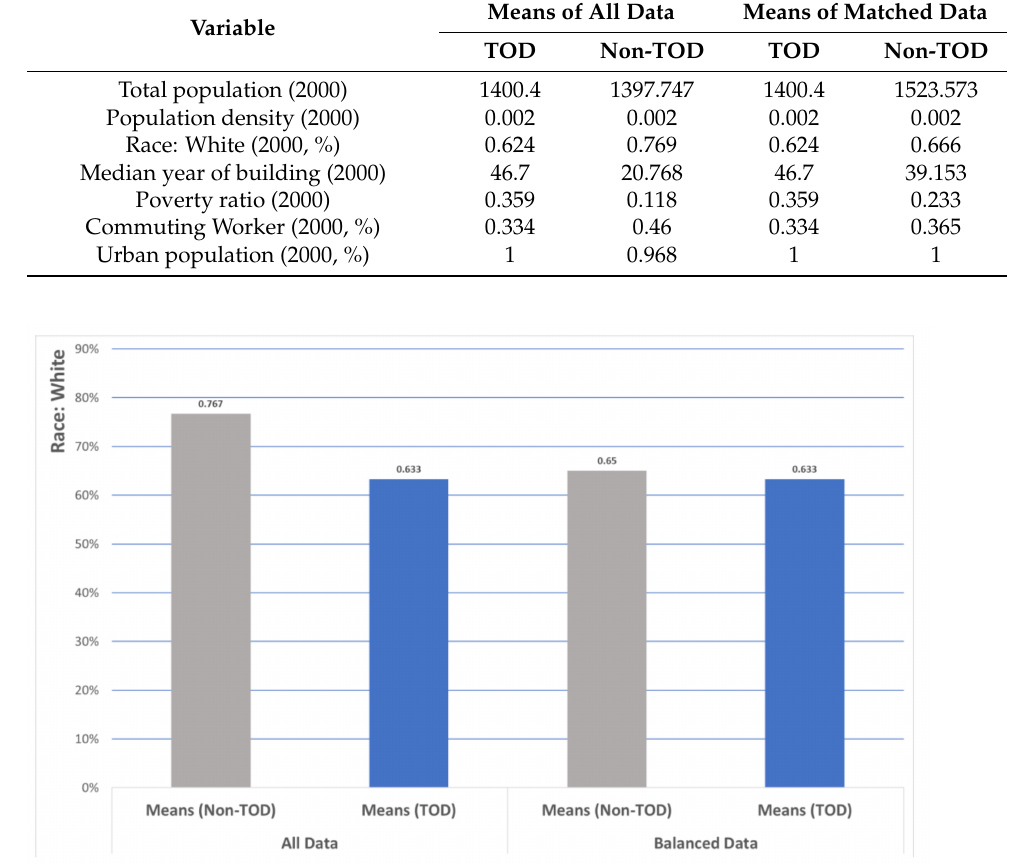
Figure 3. Comparison of TOD and Non-TOD neighborhoods (Race: White,